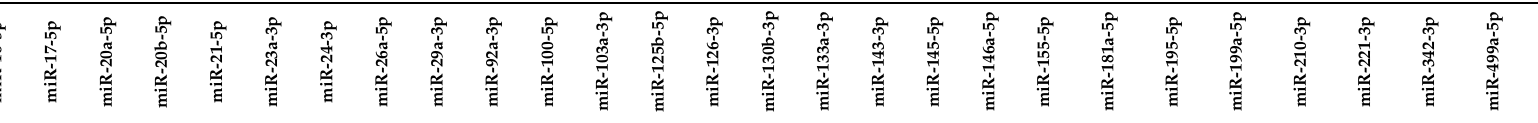
Table 1. The role of microRNAs in the development and maintenance of homeostasis in the cardiovascular system and in the pathophysiology of cardiovascular and cerebrovascular